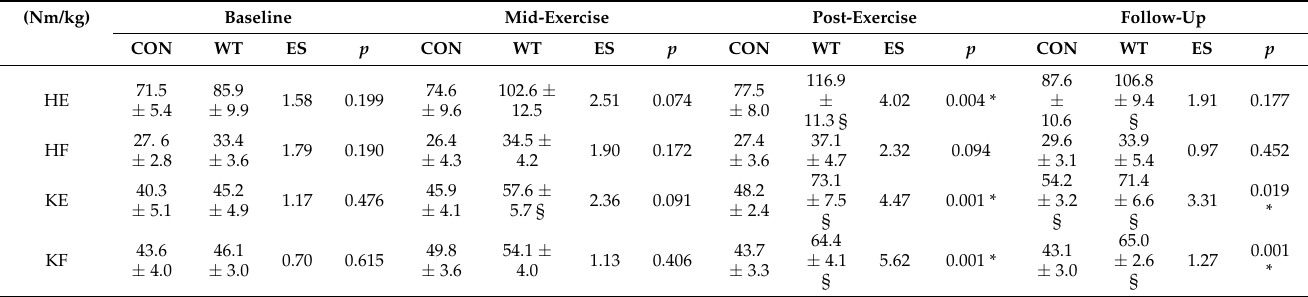
Table 2. Comparison of muscle strength between two groups of TKA patients.